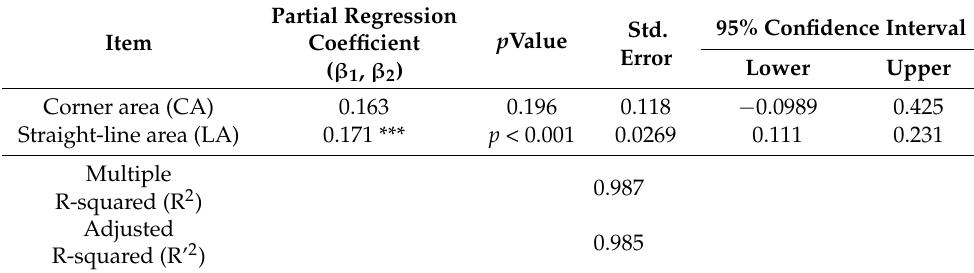
Table 10. Multiple regression analysis results using all results (MCF). Item